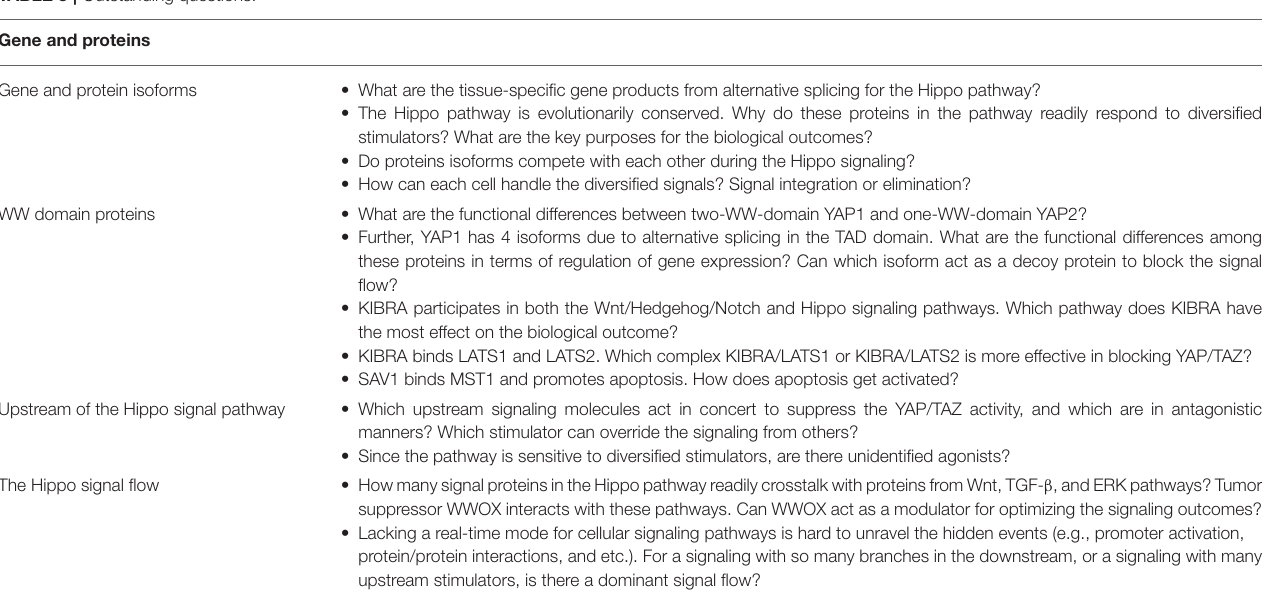
TABLE 3 | Outstanding